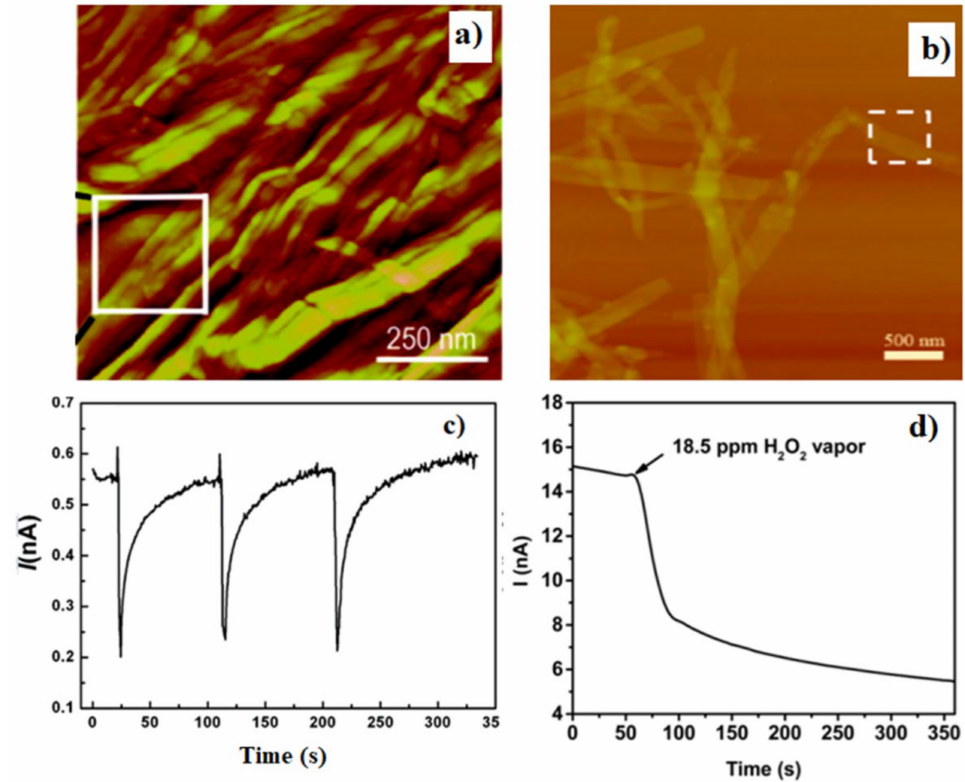
Figure 14. AFM images of ( a ) PDI-MA and ( b ) PDI-MP illustrating the ribbon-like morphology. Current change in PDI-MA nanoribbons in response to ( c ) nitromethane (36000 ppm) and ( d ) H 2 O 2 (18.5 ppm). Adapted with permission [89,90].